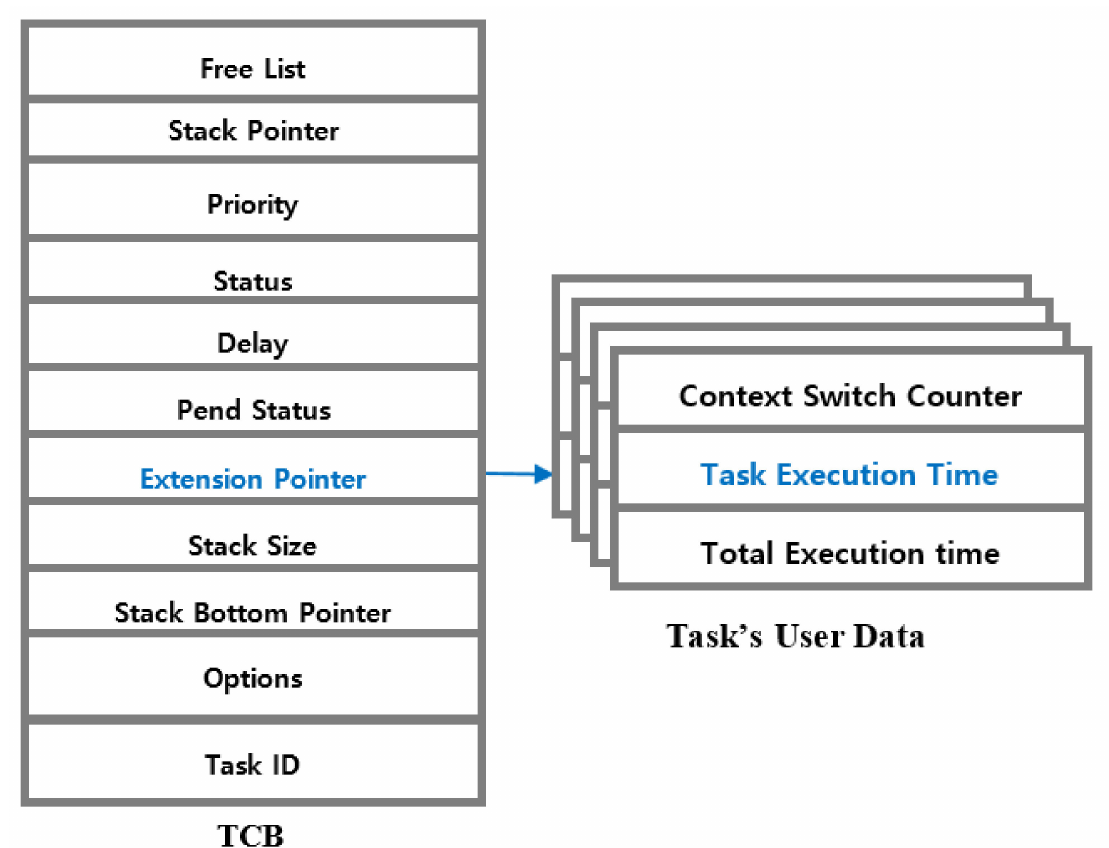
Figure 2. Task Control Block (TCB) extension for CPU usage